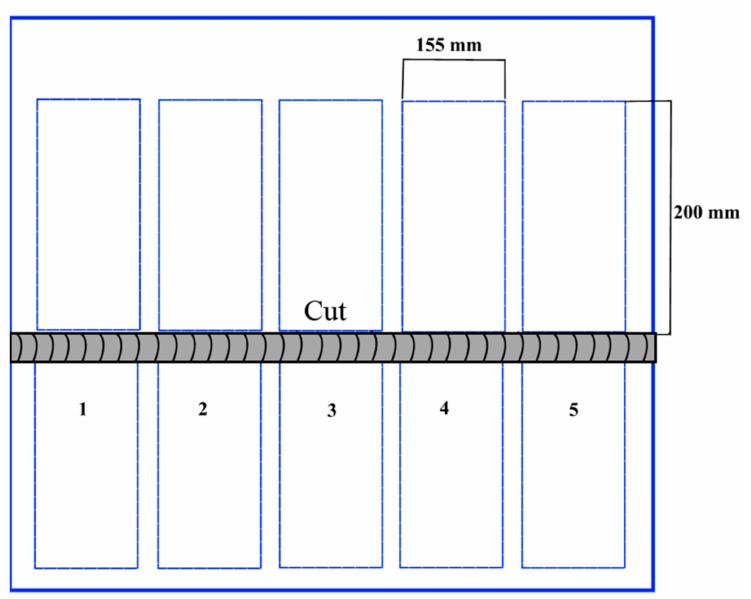
Figure 2. Schematic of the cuts performed in the lap welded joints for